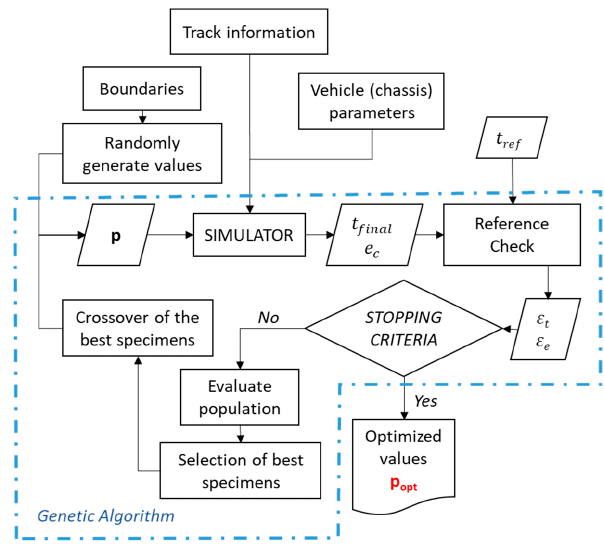
Figure 1. General flowchart of the proposed methodology.